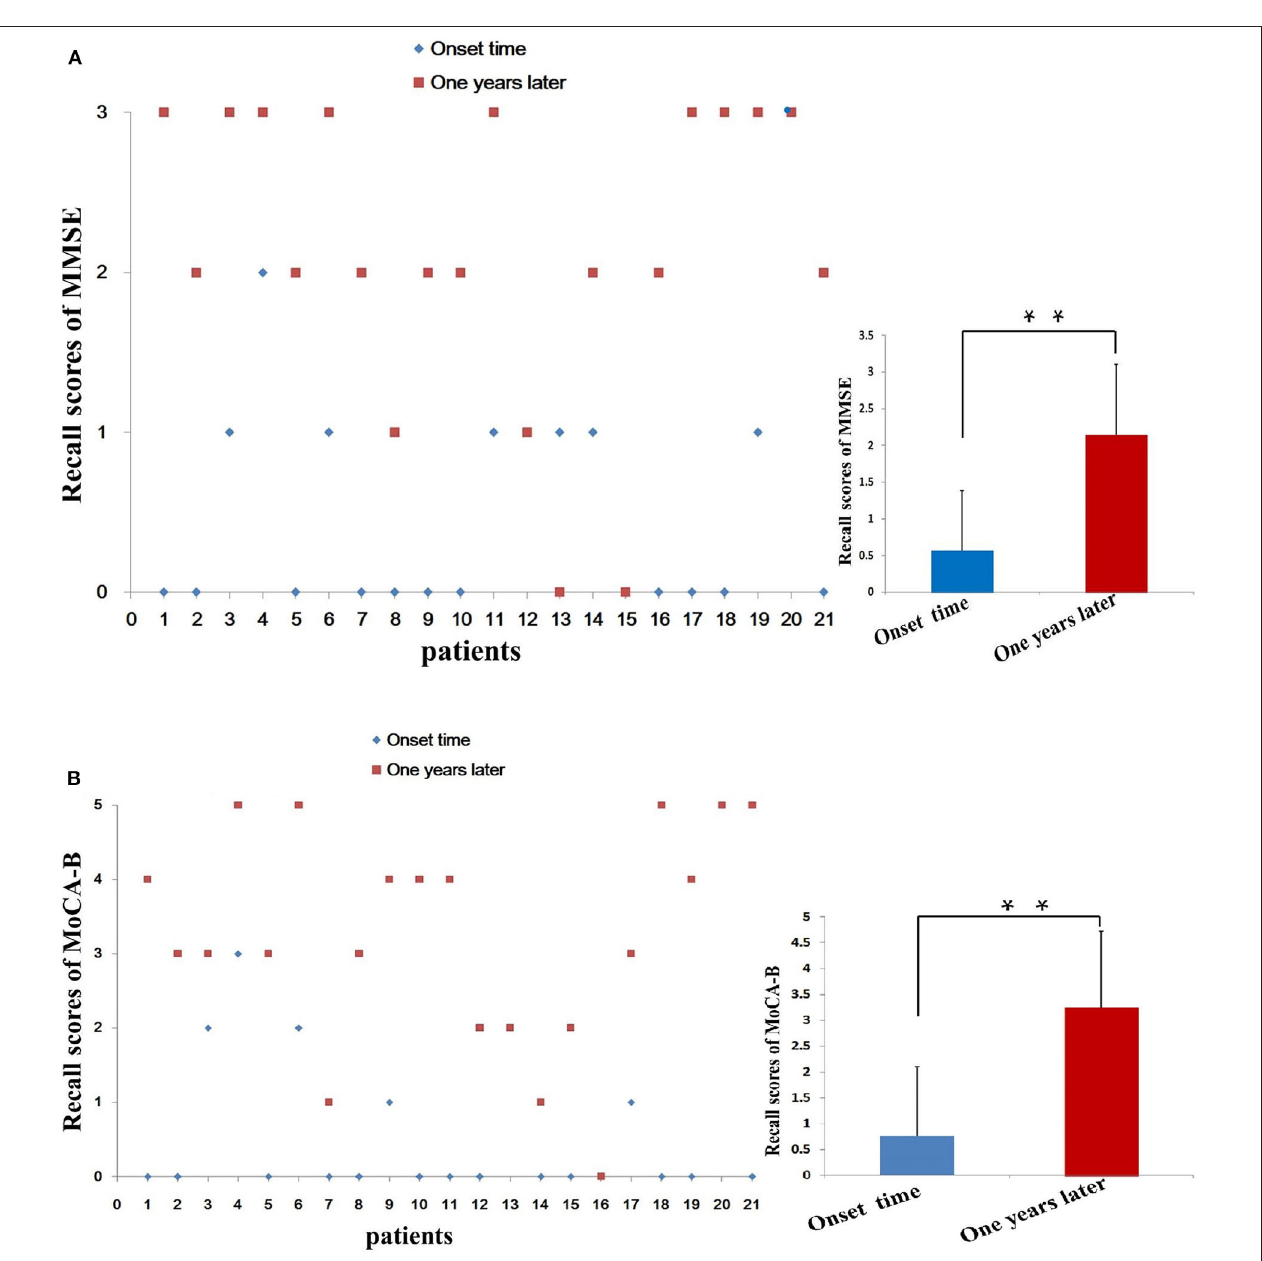
FIGURE 4 | Distribution of patients by short-term memory (recall) score. We separately list the distribution of patients with different recall scores of MMSE (A) and MoCA-B (B) . The MMSE recall items of 12 (57.14%) patients at the time of onset were scored 0 points, while only 2 patient after 1 year were scored 0 points. Only 1 patient had a normal recall of 3 points during the onset, and 9 patients got 3 points in this item after 1 year. MMSE, Mini-Mental State Examination; MoCA-B, Montreal Cognitive Assessment-Basic; ** P <